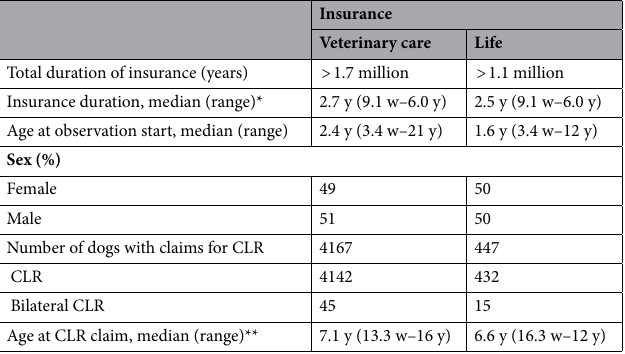
Table 1. Descriptive features of dogs insured in Agria Pet Insurance in Sweden, 2011–2016. *Per dog, during 2011–2016. **Age at first CLR claim during 2011–2016 for dogs with veterinary care insurance. CLR cruciate ligament rupture, y years, w